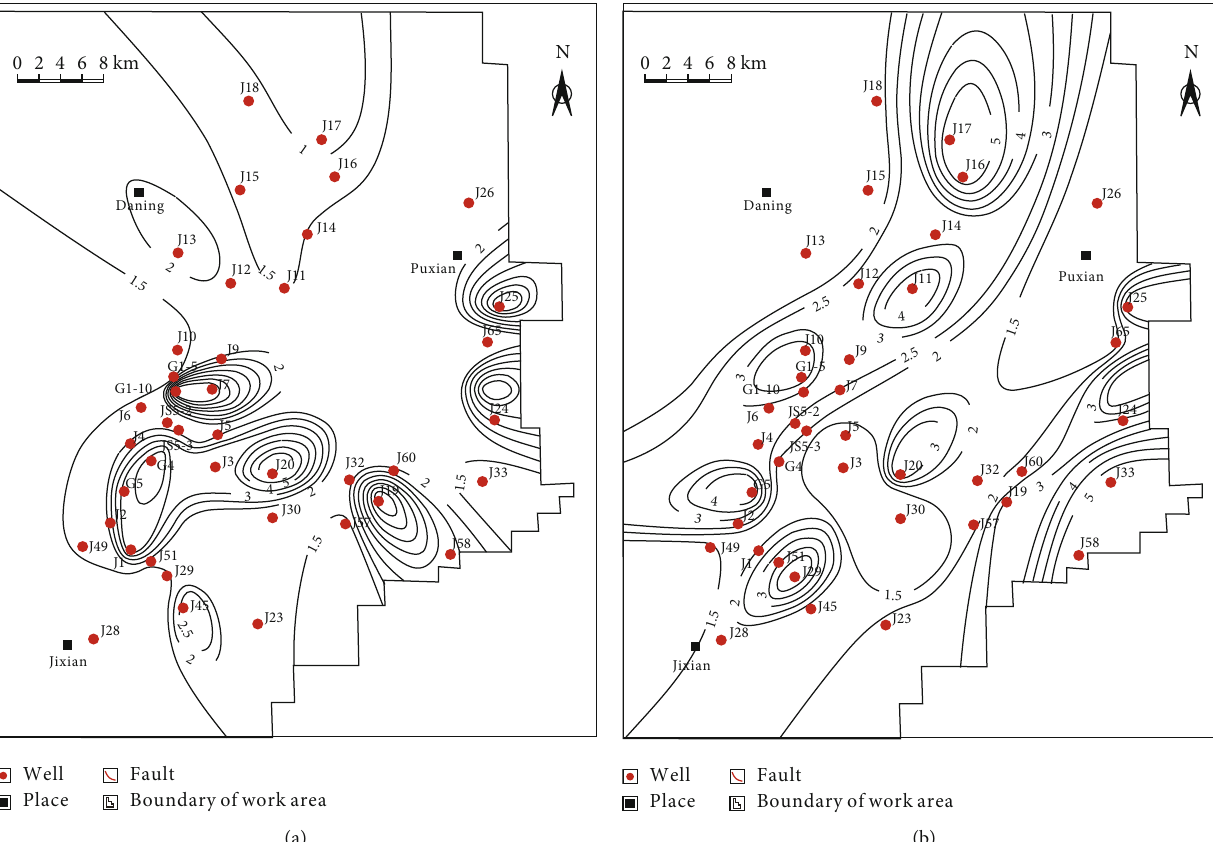
Figure 4: The contour map of the TOC of mud (shale) reservoirs in the study area. (a) Shanxi Formation; (b) Taiyuan